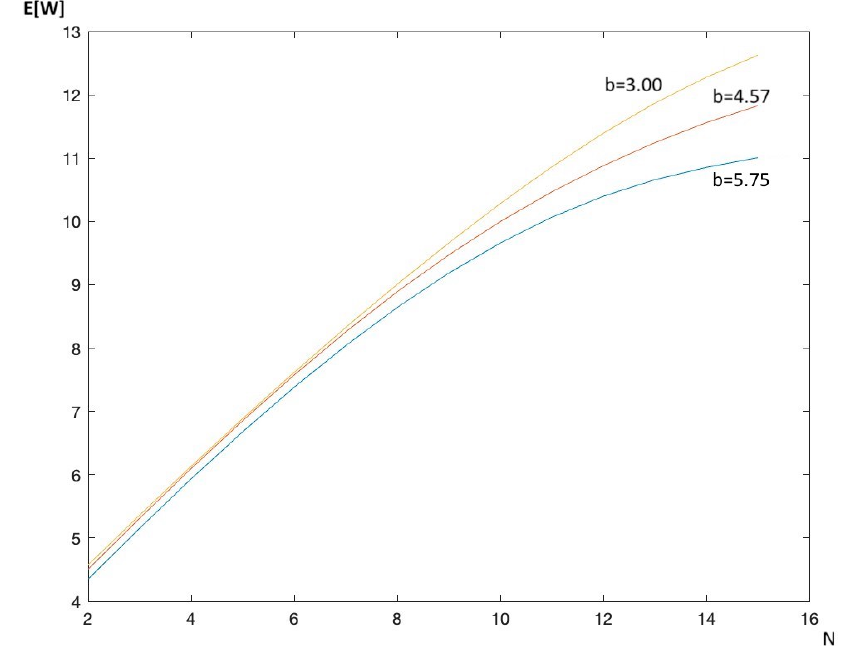
Figure 4. Mean waiting time as a function of 𝑁 for different values of the burstiness of the input.